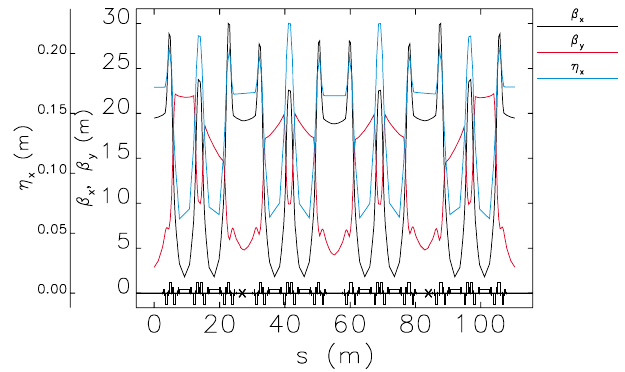
FIG. 4. (Color) Lattice functions corresponding to arrangement (b) from Fig. 3. The approximate locations of the cavities are marked with an